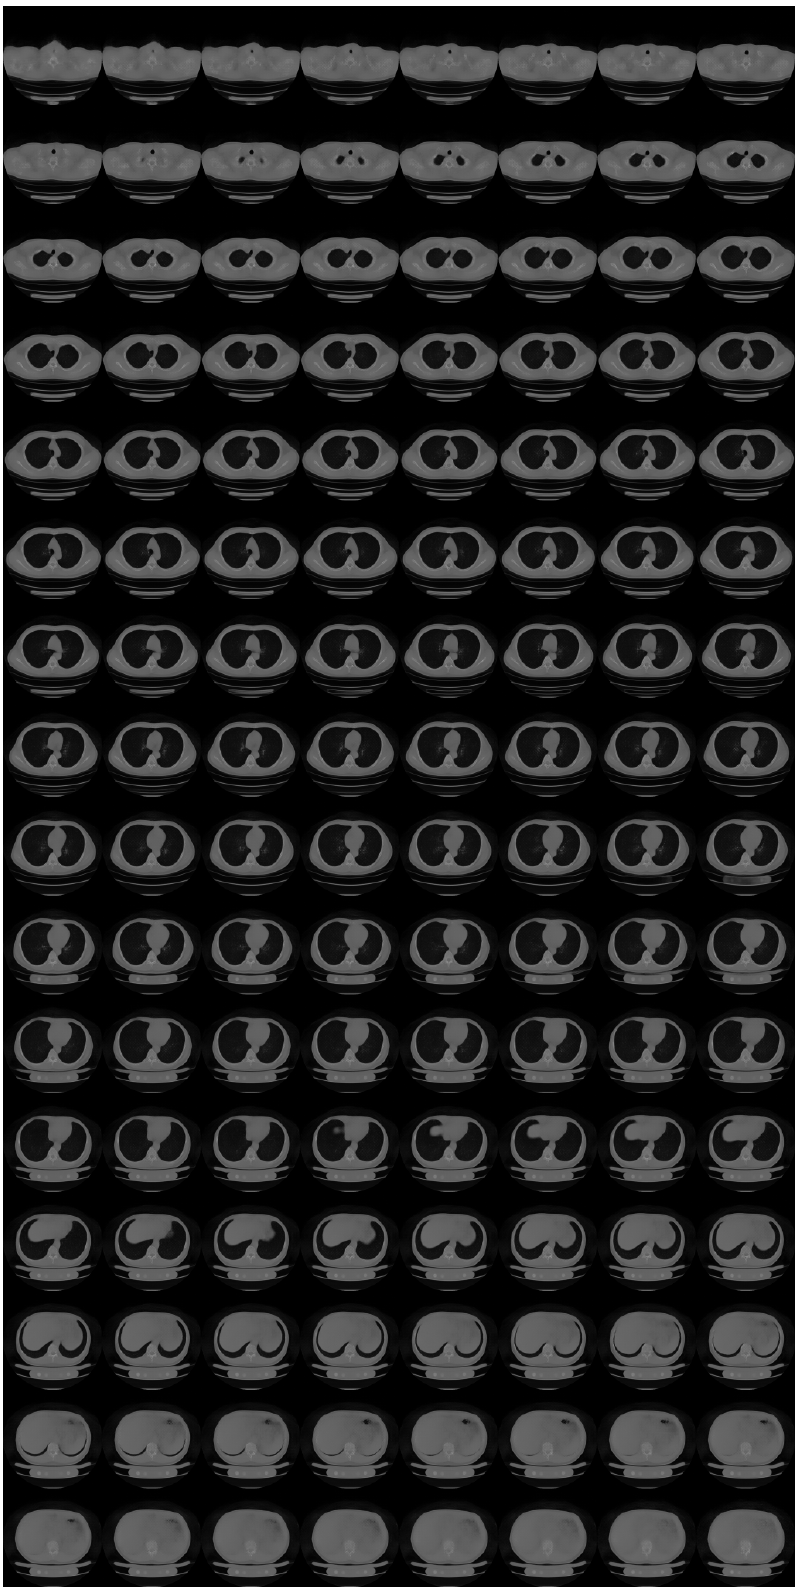
Figure A4. Fictional 3D CT image at the final epochs (sampled with T = 0.5, progressive learning, 2 of